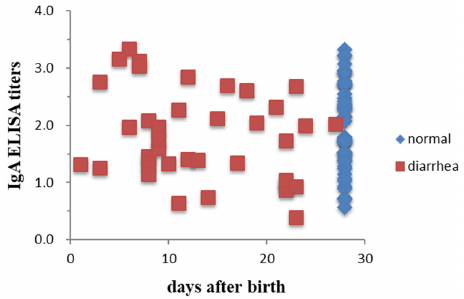
Figure 2. Comparison of the distribution of ELISA IgA antibody titers against PEDV in piglets with or without diarrhea in farm SL. Each point represents one litter, and colostrum was collected from sows on the day of farrowing ( n = 37 and 48 for litters with or without diarrhea,